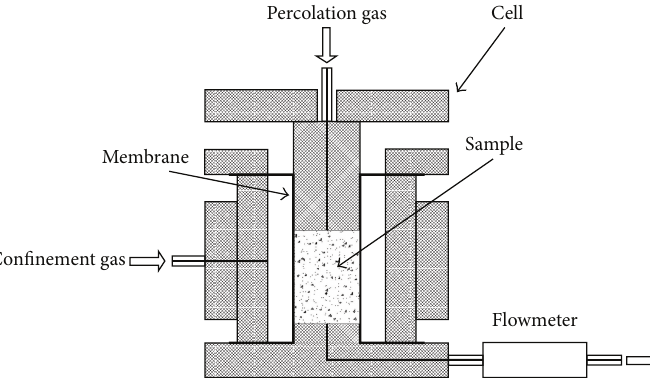
Figure 9: Scheme describing the experimental setup of permeability test.